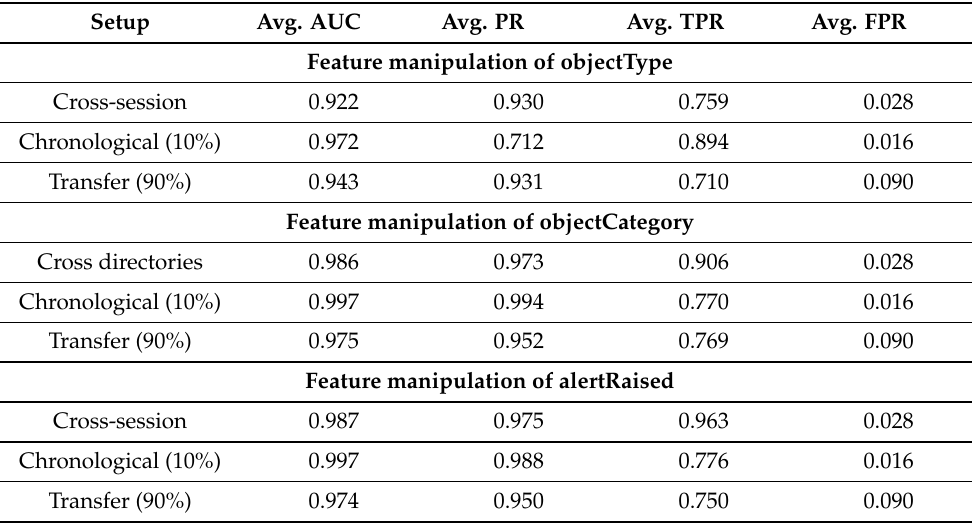
Table 2. Evaluation results obtained for predefined anomaly